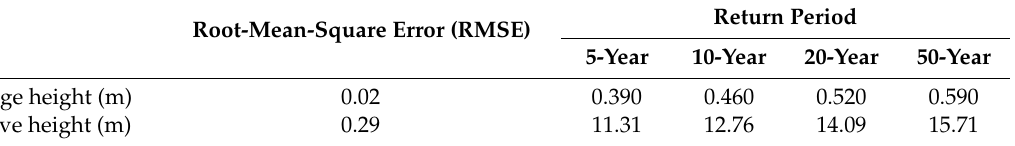
Table 5. Reliability test results for surge heights and wave heights that correspond to di ff erent return